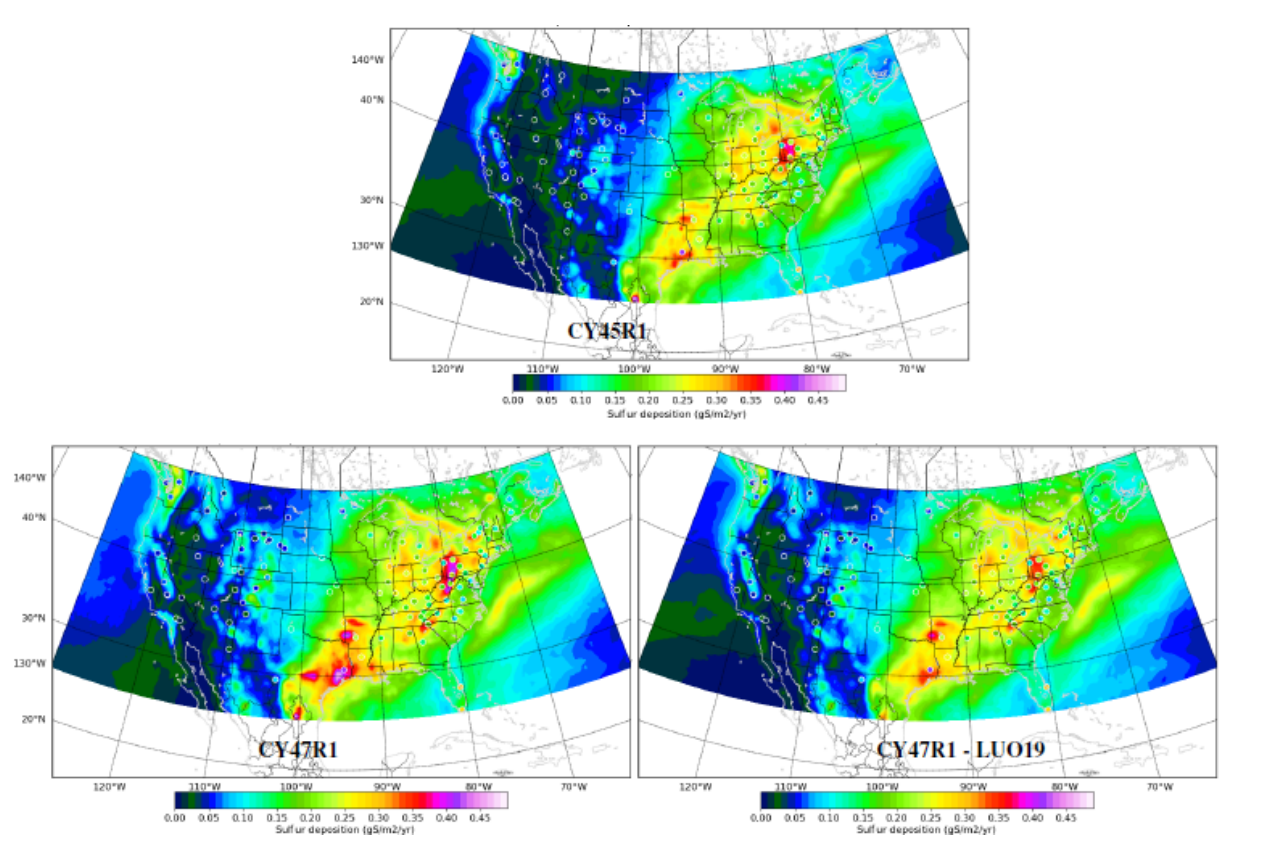
Figure 20. Simulated vs. retrieved wet deposition flux of sulfur over the United States for